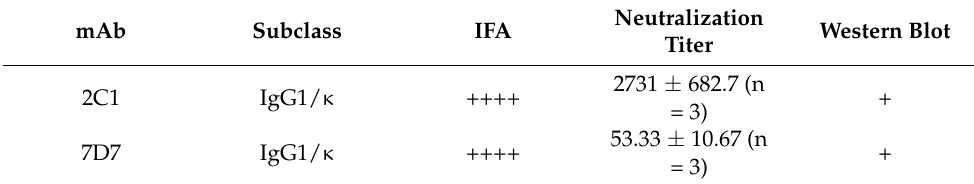
Table 3. Biological characterization of mAbs against CAdV-2.